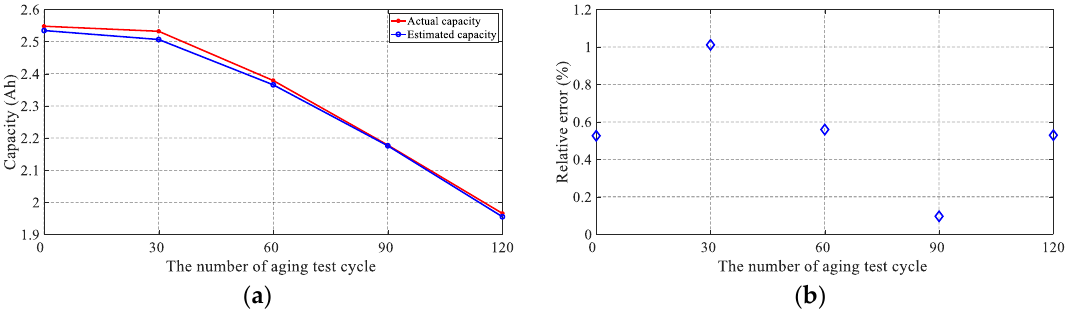
( b ) Figure 7. The results of SOC estimation based on various data lengths: ( a ) SOC estimation results; ( b ) SOC error. Figure 8. Comparison of the battery SOC estimation results of different data lengths. 4.2. SOC Estimation Under Various Degradation Stages To verify the feasibility of the proposed co-estimation scheme, the battery cells are experimentally and circularly tested with the UDDS current at different aging levels. According to the estimation algorithm of capacity addressed previously, the pre-set data length is 200 minutes.